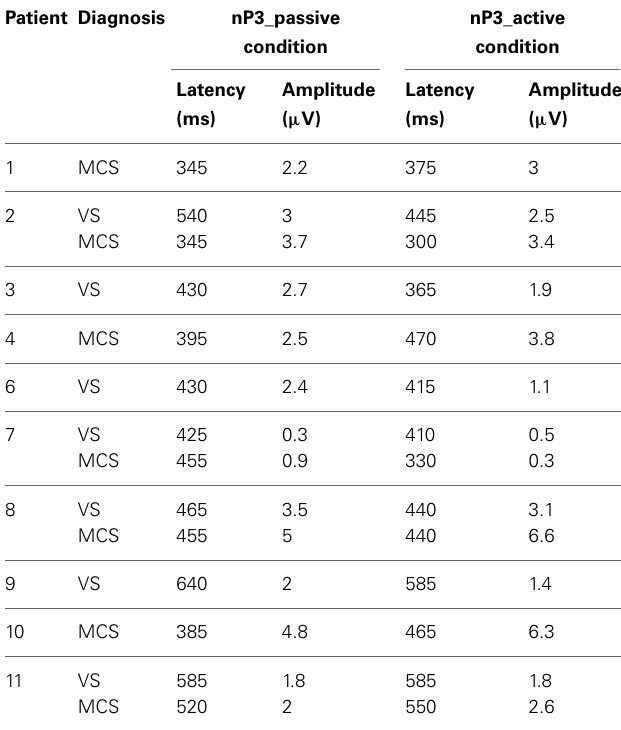
Table 2 | Average of the nP3 latency and amplitude values for each patient